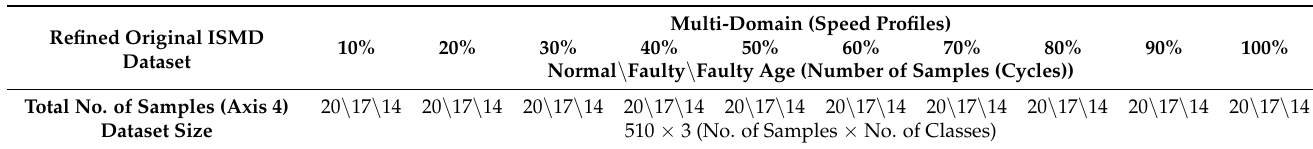
Table 3. Original ISMD data.